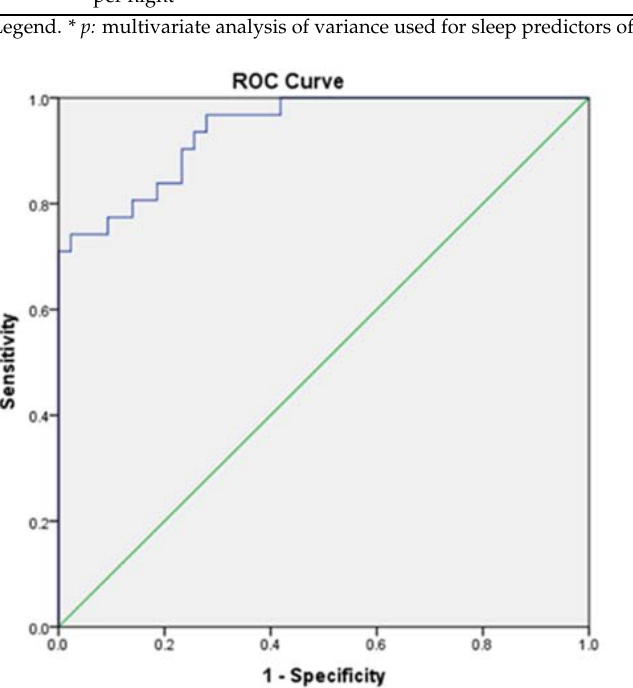
Figure 1. ROC Curve for sleep predictors of MHE (AUC = 0.940; sensitivity = 0.839; specificity = 0.814).